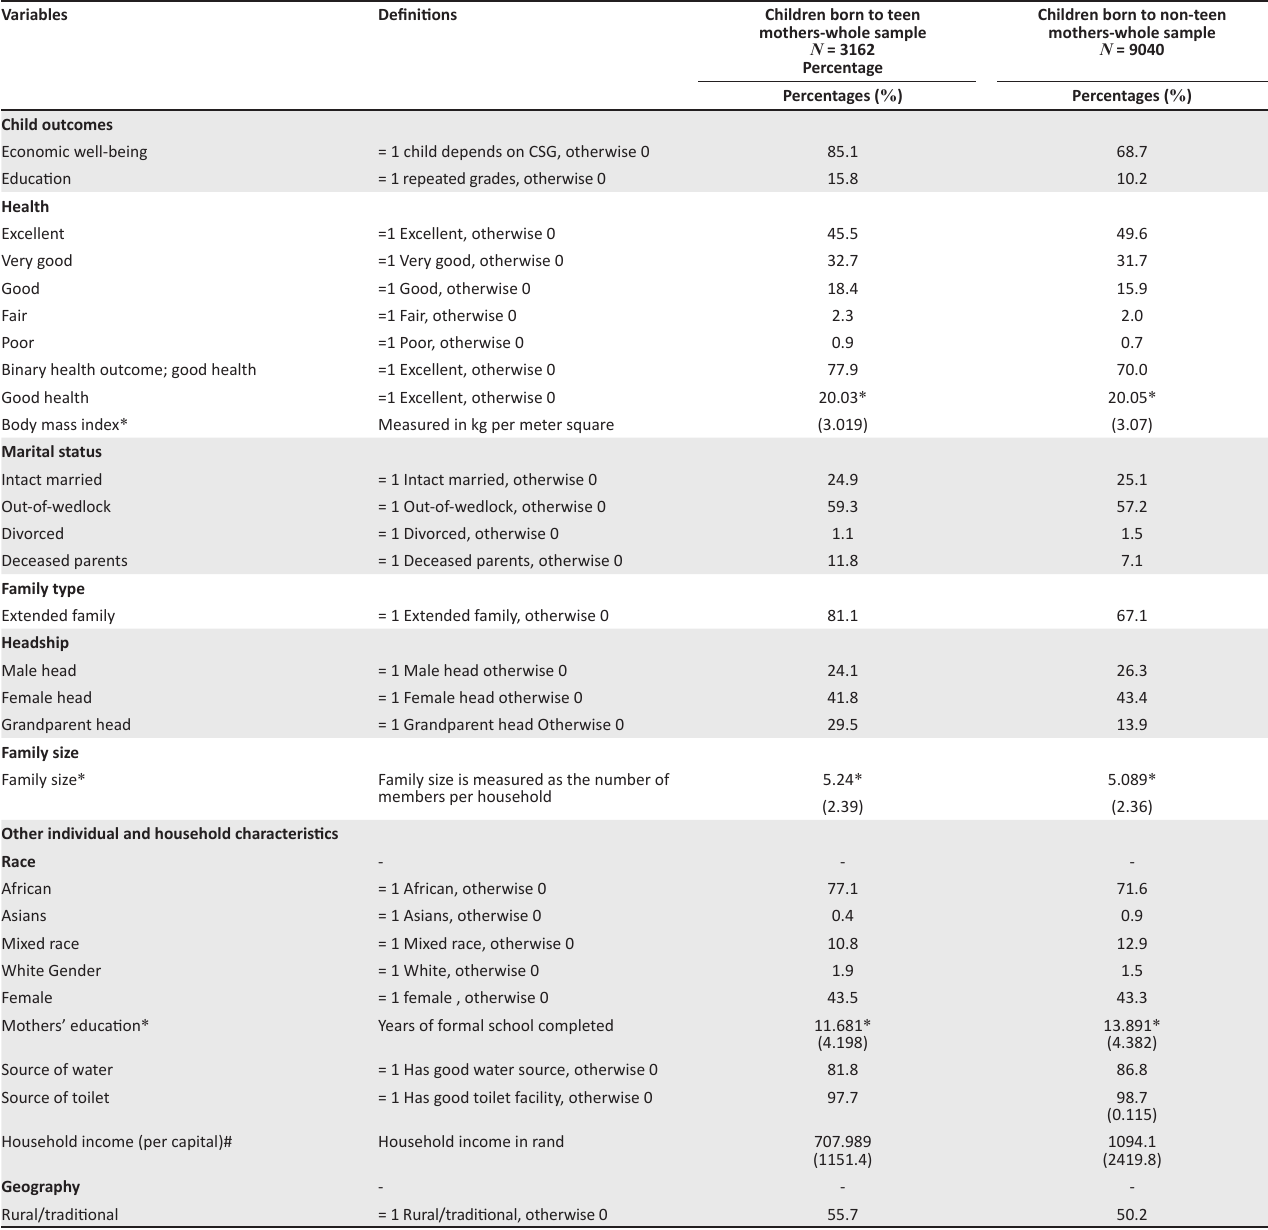
TABLE 1: Summary statistics.